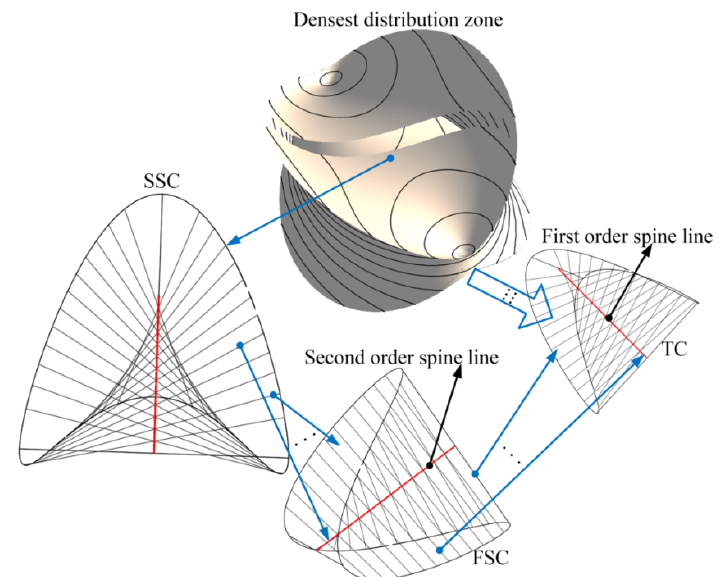
Figure 9. Decomposition of the densest distribution zone.